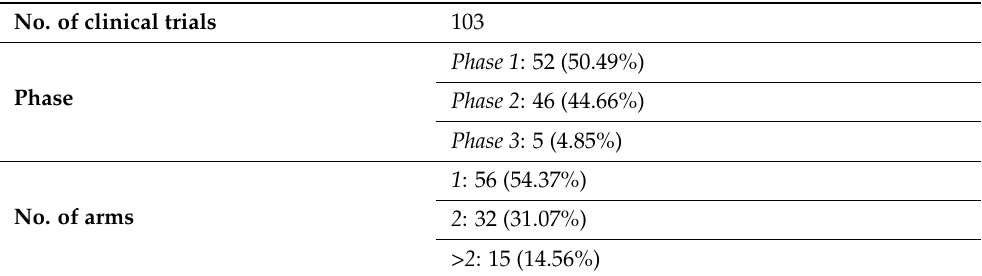
Figure 2. Preferred Reporting Items for Systematic Reviews and Meta-Analyses protocol used for the present review. Table 1. Summary of clinical trials currently ongoing for investigating pharmacological agents for the management of rGBM.